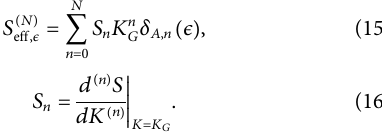
FIGURE 1 (A) ThenormalisedGamowpeakfor ϵ valuesof0.02and0.05. The solid lines use the exact form and the dashed lines show the saddlepoint approximation, which is valid for ϵ ≪ 1. (B) The ratio of fi ned inEq. 13)to S ( K G )for theresonant D (T,n) α and S eff (as de non-resonant D (D,n) 3 He reactions. These are evaluated using the Bosch-Hale cross section fi t